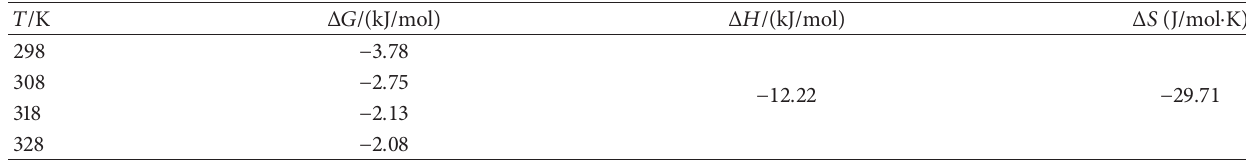
Table 5: Thermodynamic parameters for the adsorption of MB on